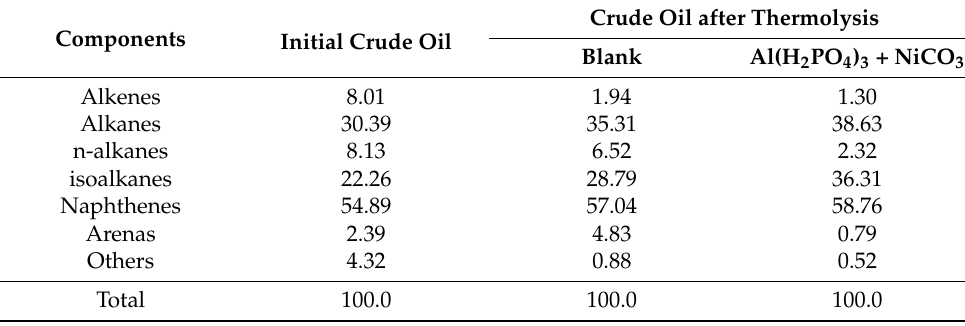
Table 2. Group composition of gasoline fractions from oil after